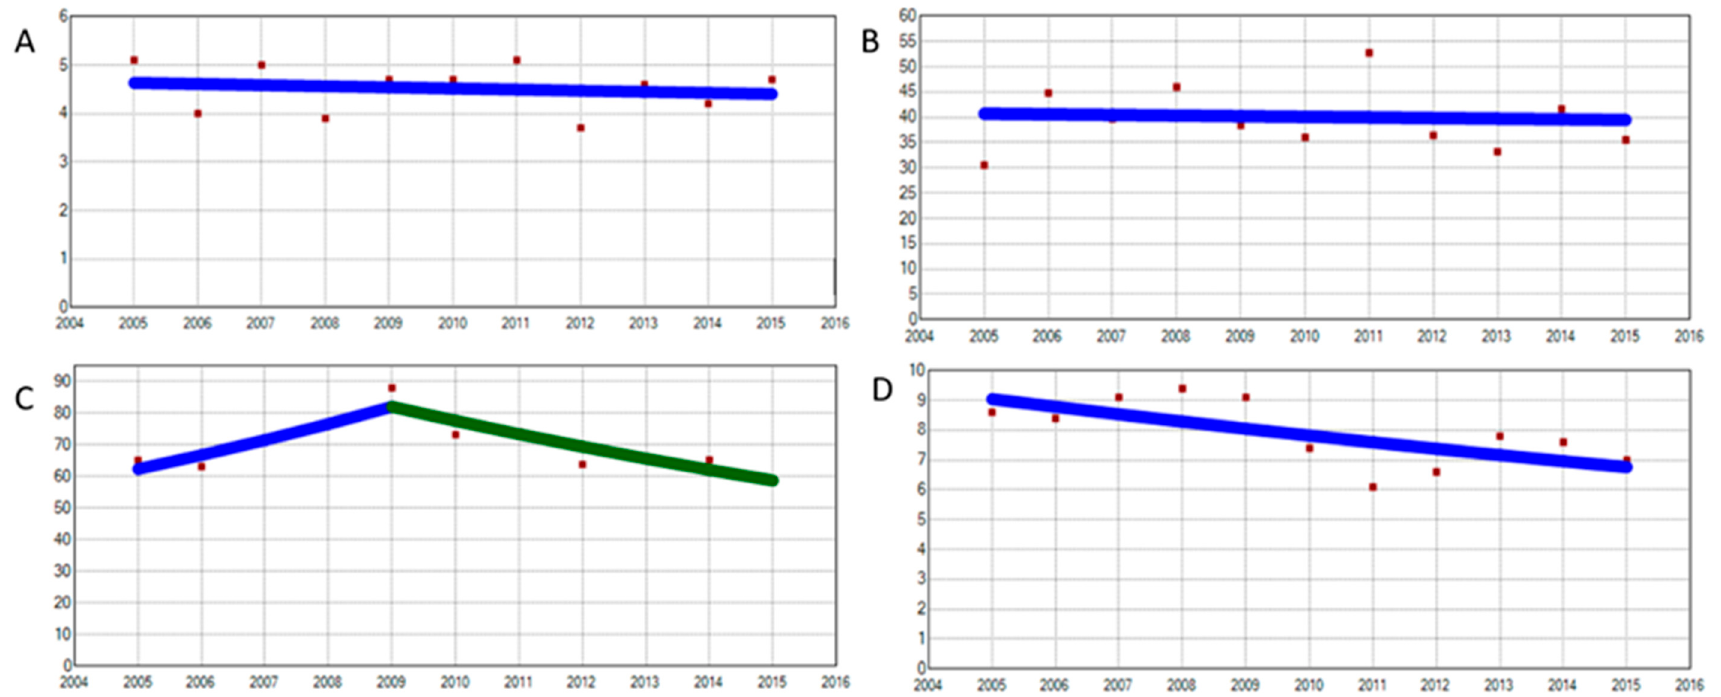
Figure 2. Trends in psychiatric hospitalization by age quartiles. ( A ) First quartile, 0 joinpoint, APC 2005–2010 − 0.5 (95% CI − 2.9 to 2, p = 0.7). ( B ) Second quartile, 0 joinpoints, APC 2005–2015 − 0.3 (95% CI − 4.1 to 3.6, p = 0.9). ( C ) Third quartile, 1 joinpoint, APC 2005–2009 7.1 (95% CI 1.8 to 12.7 p < 0.01) APC 2009–2015 − 5.4 (95% CI − 7.9 to − 2.9; p < 0.01). (D) Fourth quartile, 0 joinpoints, APC 2005–20015 − 2.9 (95% CI − 5.5 to − 0.1, p < 0.01*). APC: annual percentage change; 95% CI: 95% confidence interval. (*): APC statistically significant. Red dots: exact annual value. Lines represent trends, with line colors changing where joinpoints were identified. A blue line only represents a monotonic trend. X -axis: years (from 2004 to 2016). Y -axis: discharge rate for each dementia studied; discharge rates for drugs/1000 hospital discharges. APC: annual percentage of change. 95% CI: 95% confidence interval. Data represent exact annual value. * Statistically significant CAP. Note: some exact annual values (red dots) might be overlapped by the regression line in some graphs (see graph 2C 2007 and 2008).